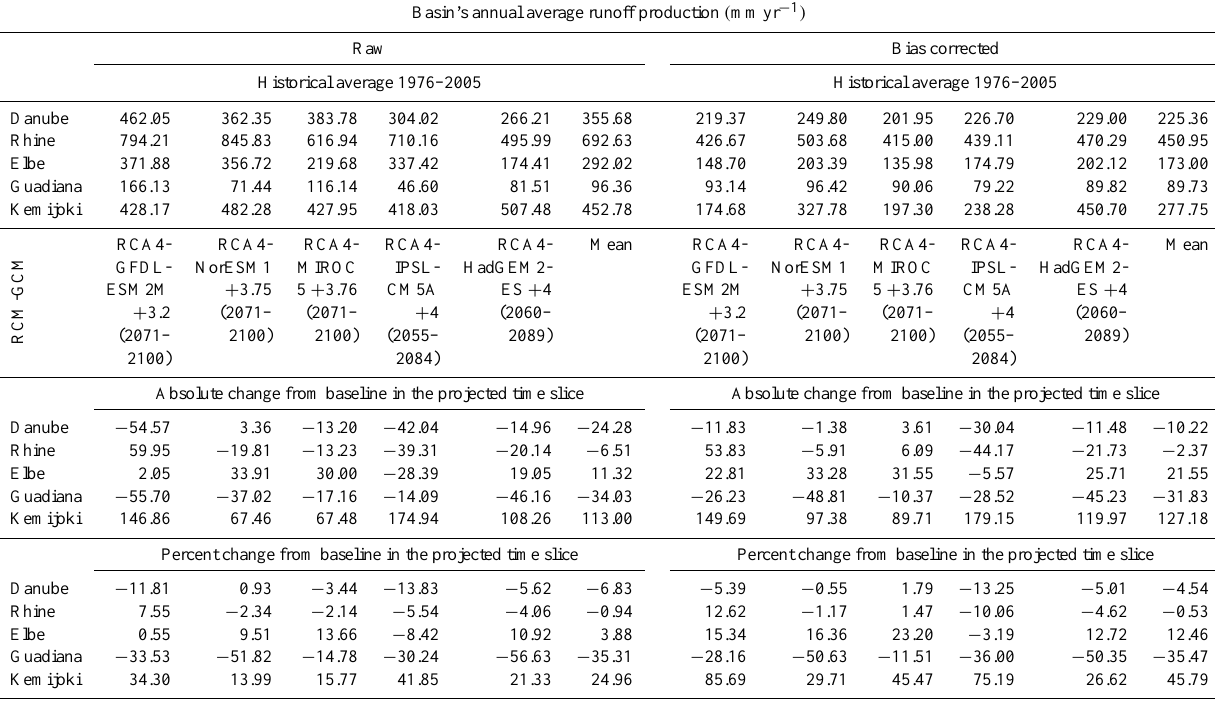
Table 2. Basin’s annual average runoff production for raw and bias adjusted Euro-CORDEX data.